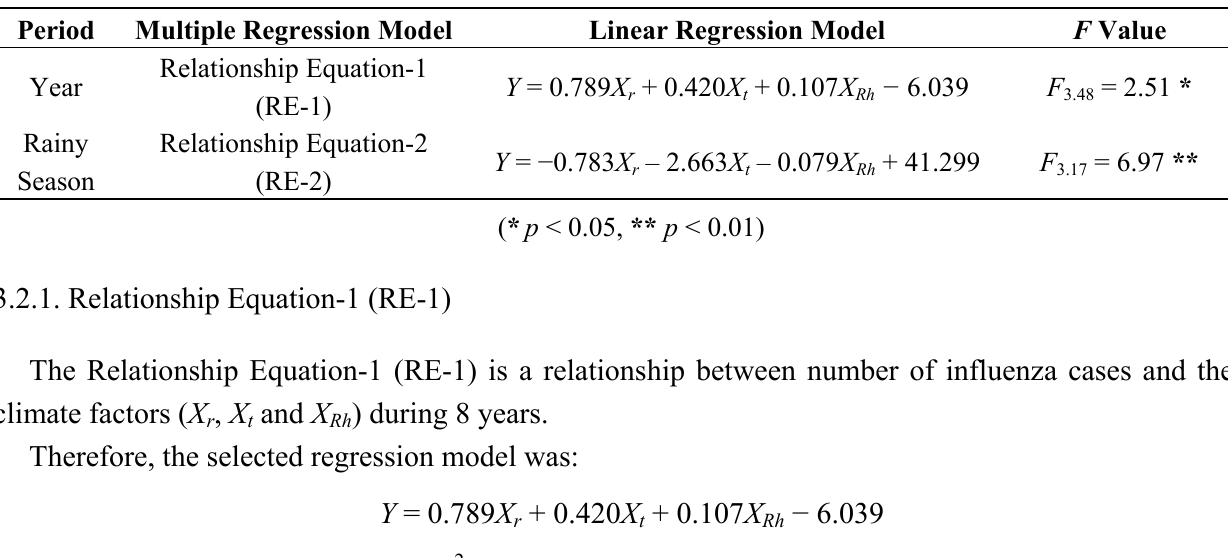
Table 3. Linear regression models on climate factors and influenza cases in Chiang Mai Province.